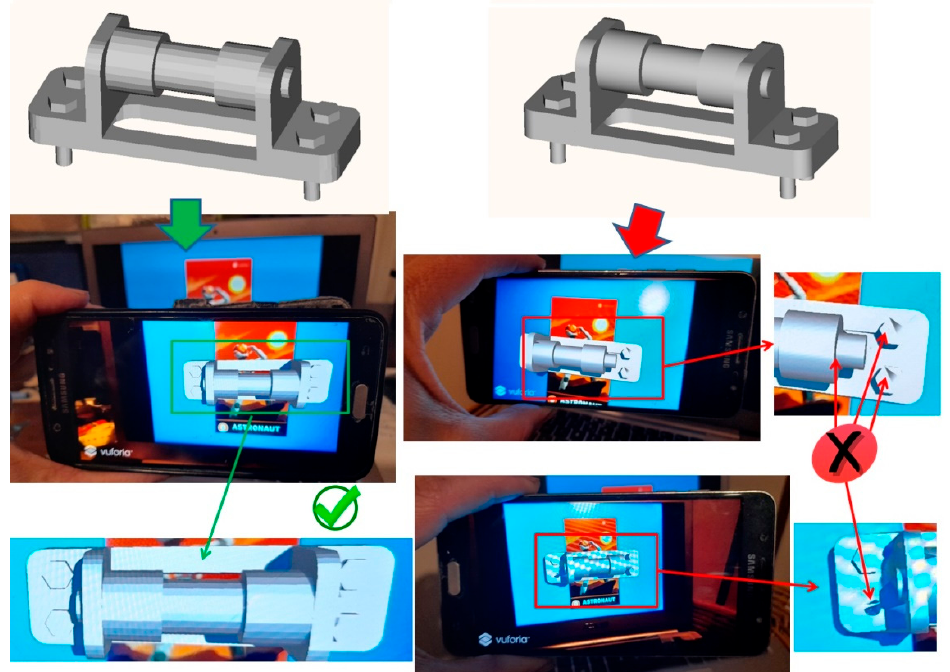
Figure 7. ARdroid application developed in Unity by authors. Top left and right: high- and low-resolution CAD model. Bottom left and right: low- and high-weight OBJ model in ARdroid application.